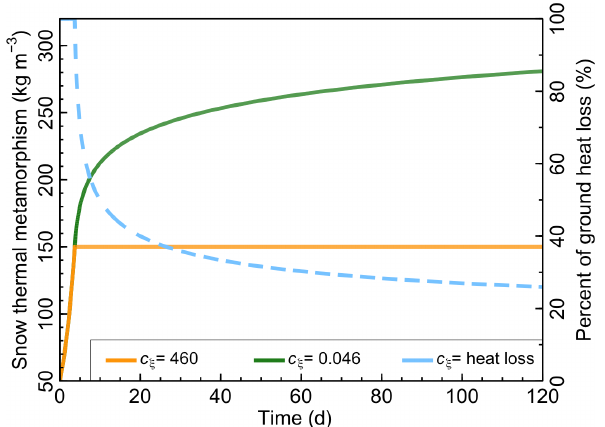
Figure 1. Snow compaction rate due to thermal (destructive) meta- morphism (excluding liquid water) using different c ξ in Eq. (6). The dashed line is the percent of ground heat loss through the snow layer in Exp. MLS-Dis+Den compared using the c ξ of 0.046 (kgm − 3 ) in ERA5L, Exp. CTRL, and Exp. MLS-Std (see text for